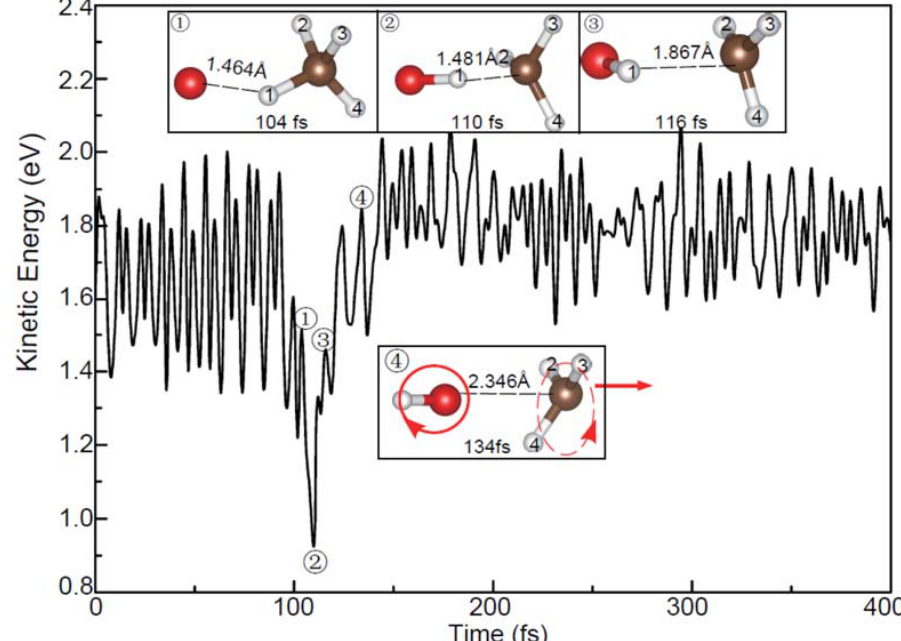
Figure 7. Evolution of the total kinetic energy and snapshots in the reaction of the vibrating CH 4 with the O − with the kinetic energy of 1.0 eV. The circle and the arrow represent the molecular rotating and moving directions.